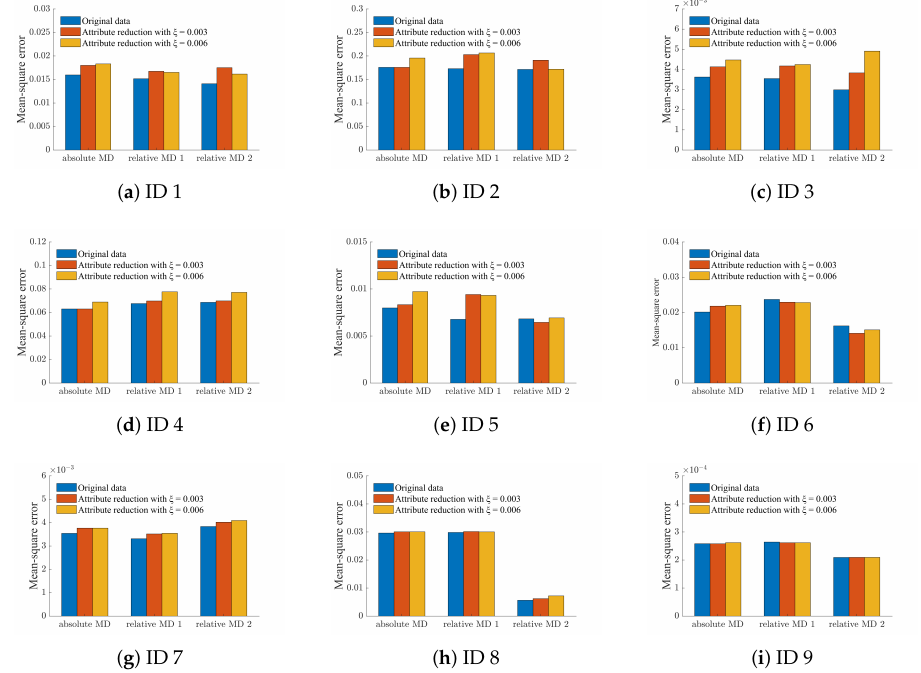
Figure 6. Average value of the mean-square error on each dataset. Each dataset is represented by ID